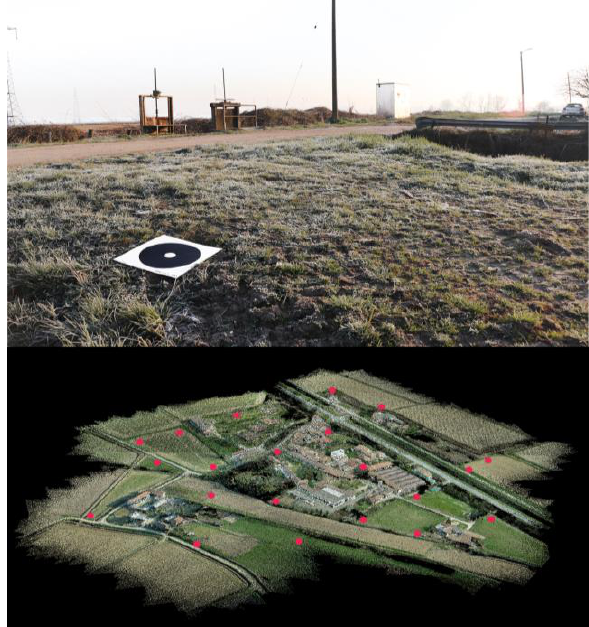
Figure 1 . The target positioning in the study area and the database obtained with DJI Phantom